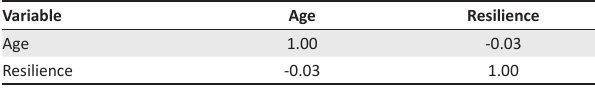
TABLE 3: Spearman’s rank order correlation.